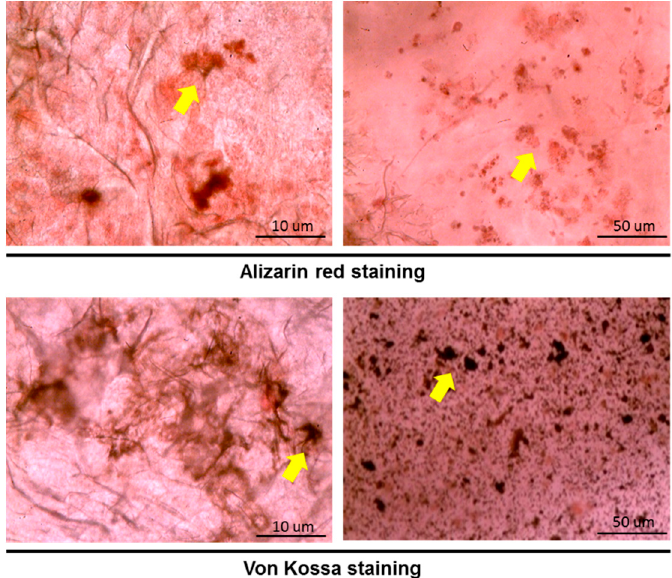
Figure 7. Evaluation of the mineralization of human adipose stem cells cultured on the gelatin scaffold for 14 days upon Alizarin Red and Von Kossa staining. Yellow arrows indicate calcium or phosphate deposition.